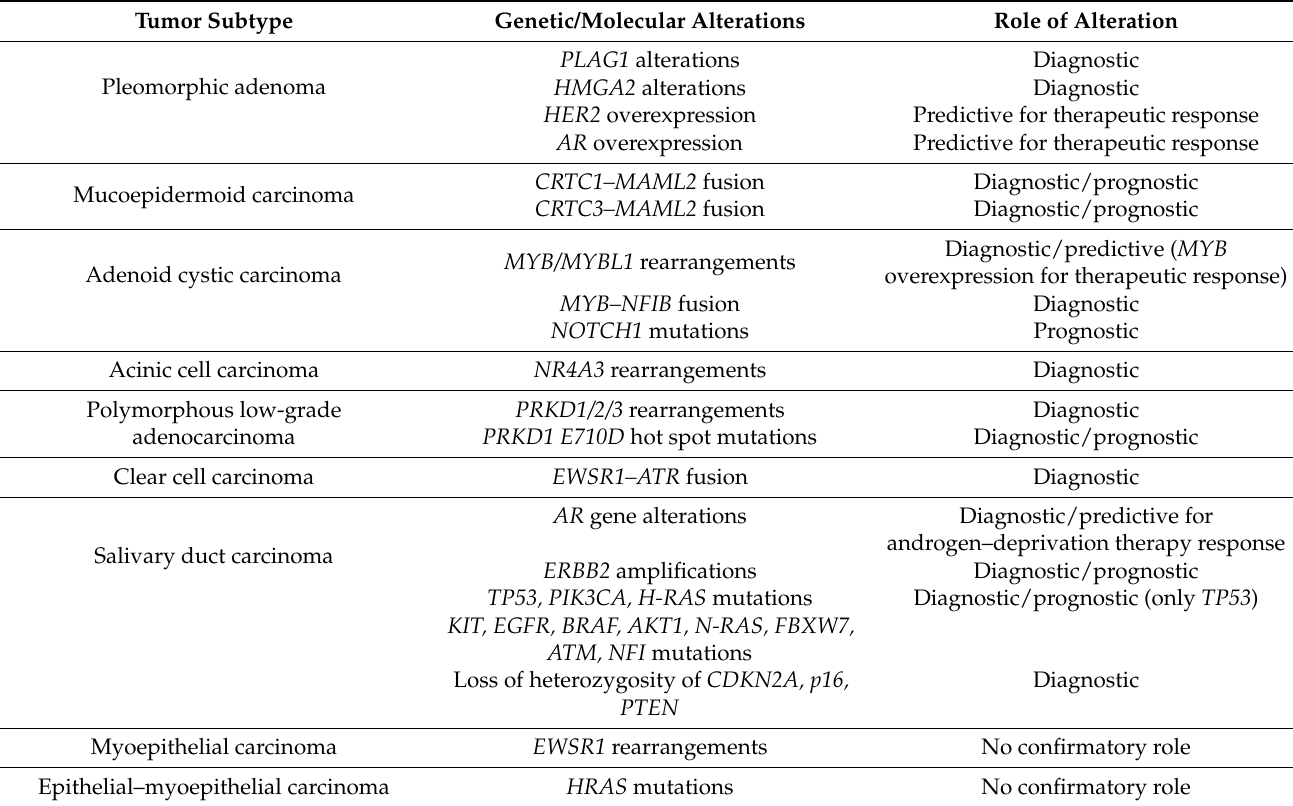
Table 4. Diagnostic, predictive, and prognostic markers in SGN. Reprinted from [47] with permission. Tumor